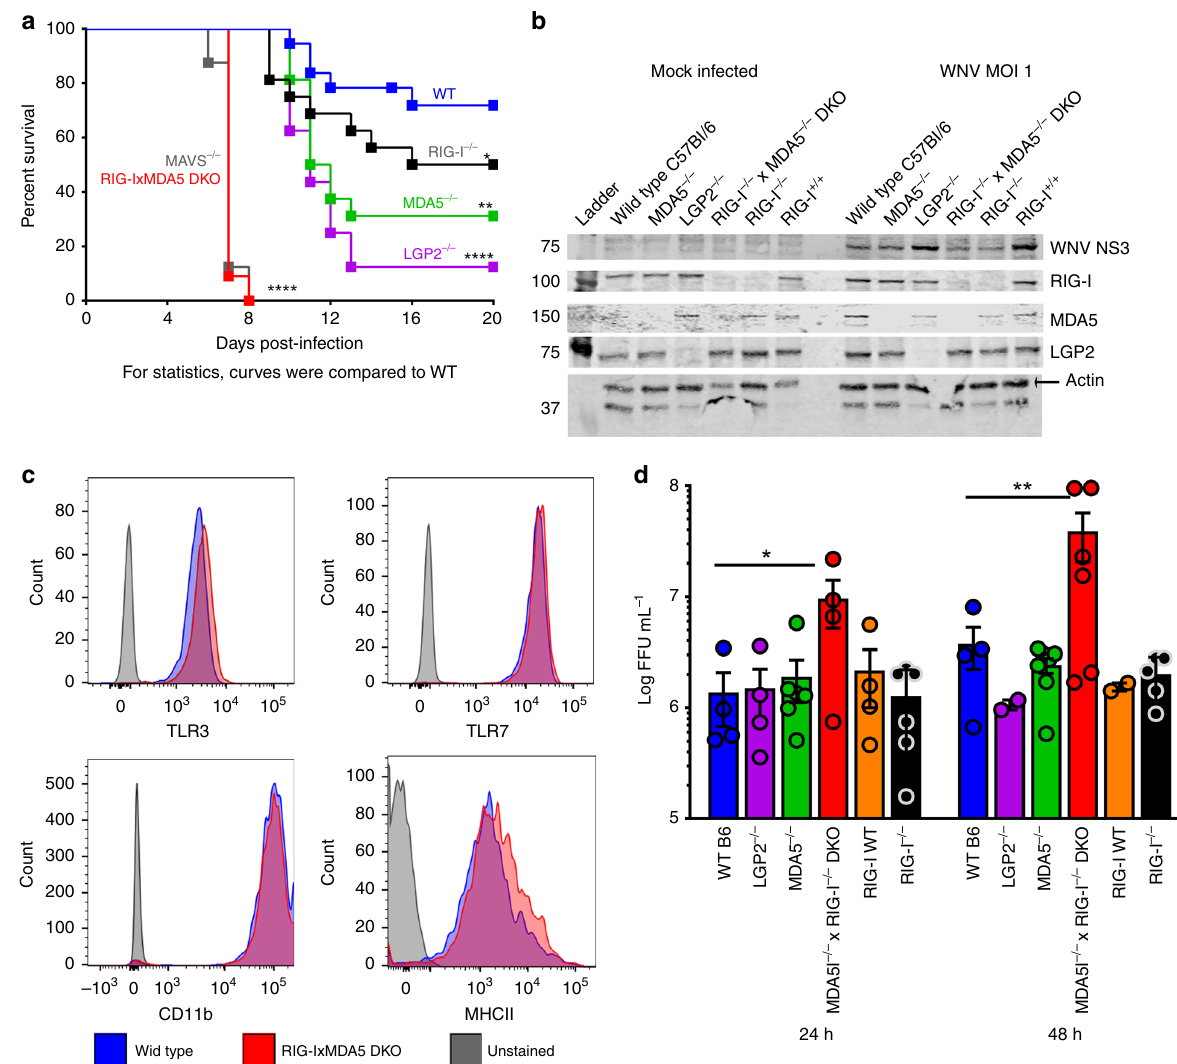
Fig. 1 RIG-I-like Receptors (RLRs) impart control of WNV infection. a Mice were infected with 100 pfu WNV in the footpad and monitored for survival for 21 days. Percent survival is shown. Signi fi cance stars for each line compared to the Wild-type (WT) line (combined C57Bl/6 [ n = 24] and RIG-I + / + WTs [ n = 12] 36 total mice) are shown. RIG-I − / − , MDA5 − / − , and LGP2 − / − n = 15 mice each; MAVS − / − n = 7 mice; RIG-I/MDA5 DKO n = 10 mice. b BMMs from each genotype were infected or mock infected with WNV at MOI 1 and harvested at 24 h post-infection. Cell lysates were assayed for the presence of RLR proteins, WNV NS3 protein, and actin by western blot. c WT (blue) or DKO (red) BMMs were stained for fl ow cytometry for TLR proteins or macrophage markers. Histograms for each assayed marker are shown. d BMMs from each genotype were infected for 24 or 48 h with WNV at MOI 2.5. The supernatants were harvested and assayed for viral load by focus forming unit (FFU) assay. Bars represent the mean viral load ± SEM from n = 3 independent sets of supernatants assayed for virus in triplicate. Panels b and c show representative data from n = 3 independent experiments. * p < 0.05, ** p < 0.01, *** p < 0.001, **** p < 0.0001 (log-rank;Mantel-Cox for survival curves and Ordinary one-way ANOVA with Holm-Sidak ’ s multiple-comparisons post-test for ffu analysis). Source data are provided as a Source Data fi le (Supplementary Fig. 5B, Supplementary Data 3), severely dysregu- lated in DKO cells. Examining the IFN response to WNV, the DE genes were divided into ISGs (as de fi ned by the WT BMM response to IFN β treatment; Supplementary Data 4) and non-ISGs (Supple- mentary Fig. 5C/Supplementary Data 5, and Supplementary Fig. 5D/ Supplementary Data 6, respectively). WNV infection induced a strong ISG response but this response was largely absent in DKO cells. ISGs segregate into functional categories consistent with macrophage activation (Supplementary Fig. 5C). By subtracting ISGs (Supplementary Data 4) from the DE gene set, we identi fi ed WNV- induced non-ISG responses occurring in all genotypes except the DKO, thus de fi ning the virus-induced macrophage response to infection beyond the canonical IFN-stimulated response.